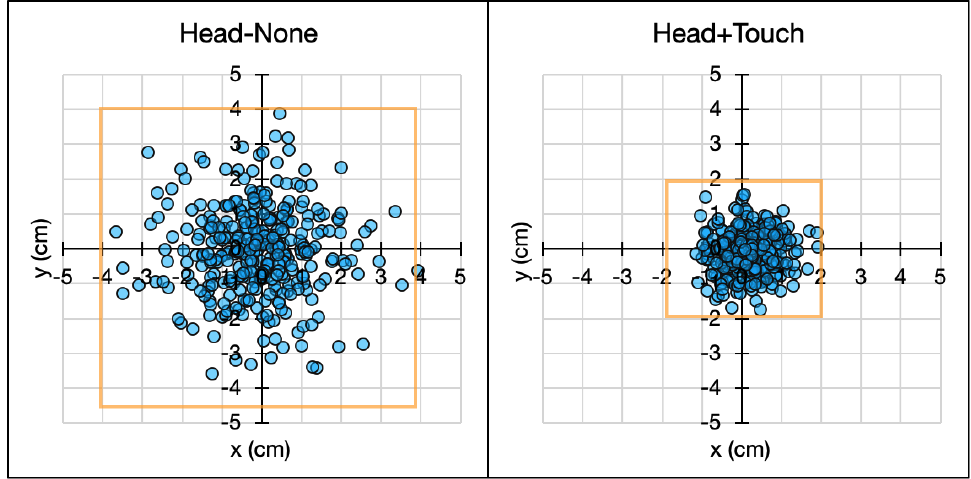
Figure 8. All selection points, showing the selection accuracy of the Head-None (no refinement) and Head-Touch (with refinement) technique. The coordinate system represents the distance from the exact target